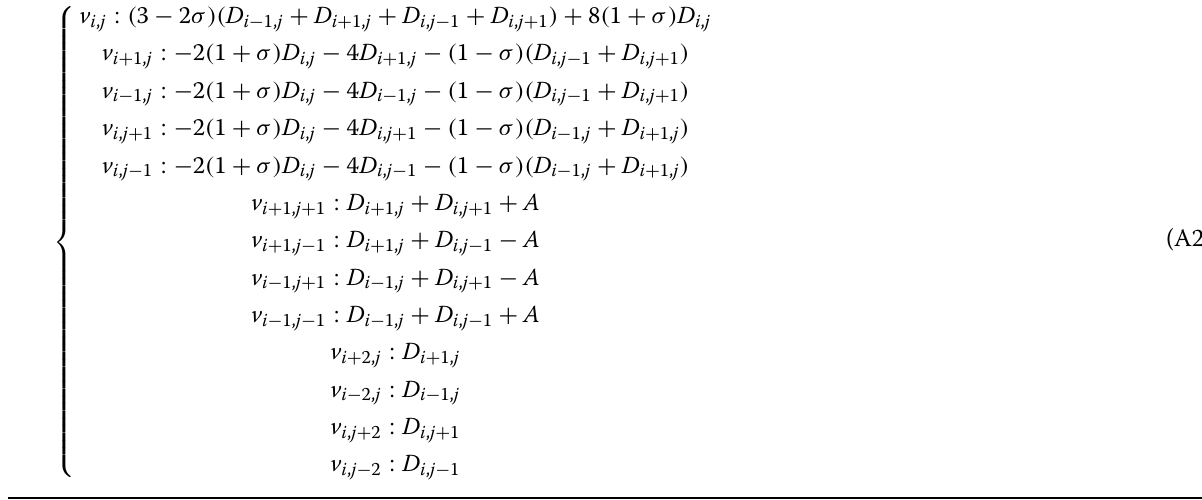
−→ v is the deflection vector (a column vector where −→ with M N rows), R is the difference coefficient matrix × h (a matrix with M N columns and M N rows), and −→ × × w are the final surface and subsurface topography and vectors (column vectors with M N rows), ×